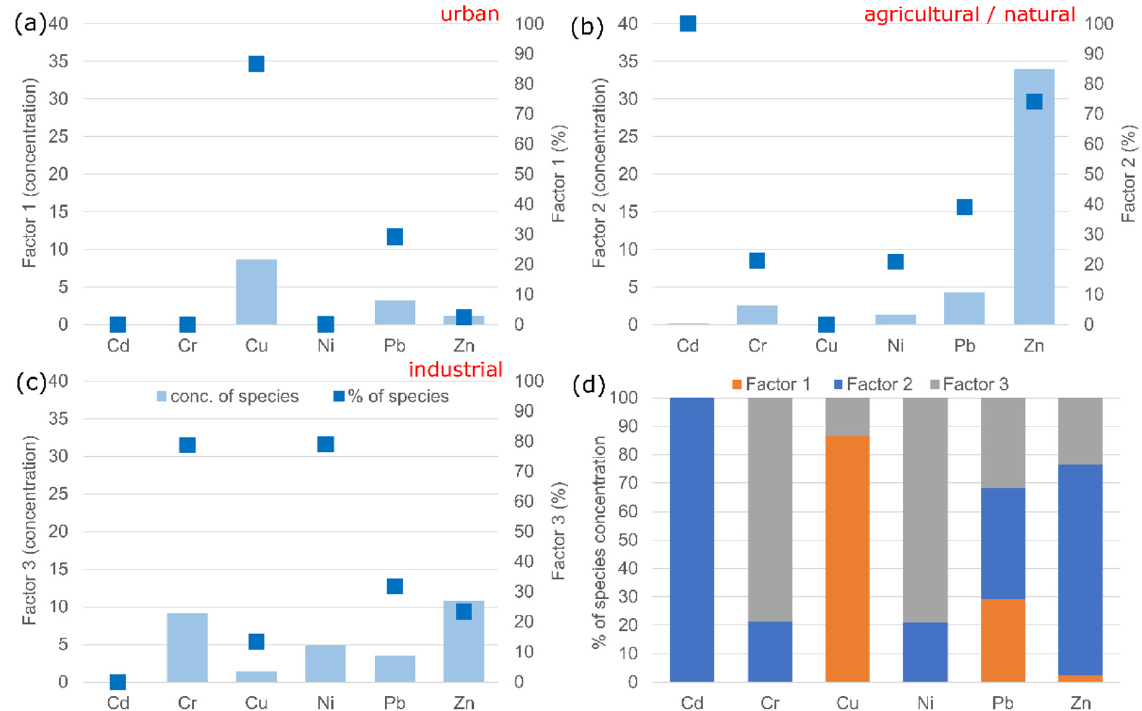
Figure 10. Source apportionment ( a – c ) and source contribution ( d ) to HM supply obtained by the PMF